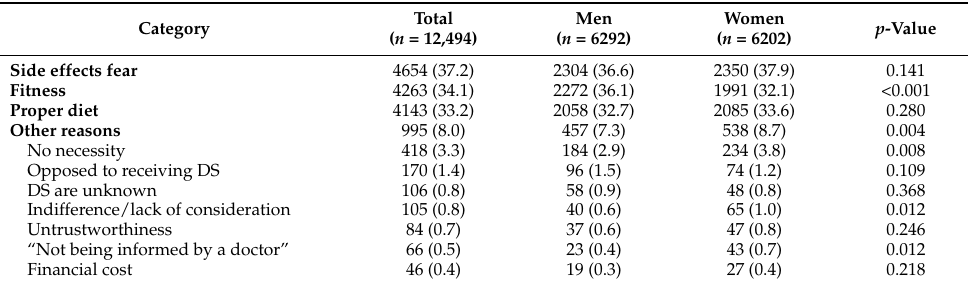
Table 4. Absolute and relative frequencies in parenthesis (%) of the reasons for DS non-use overall and according to sex. The p -values of chi-square tests are